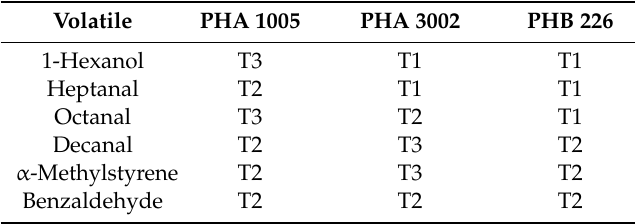
Table 5. Summary of the organoclay that works best to reduce the release of the volatile compounds studied for each polymer